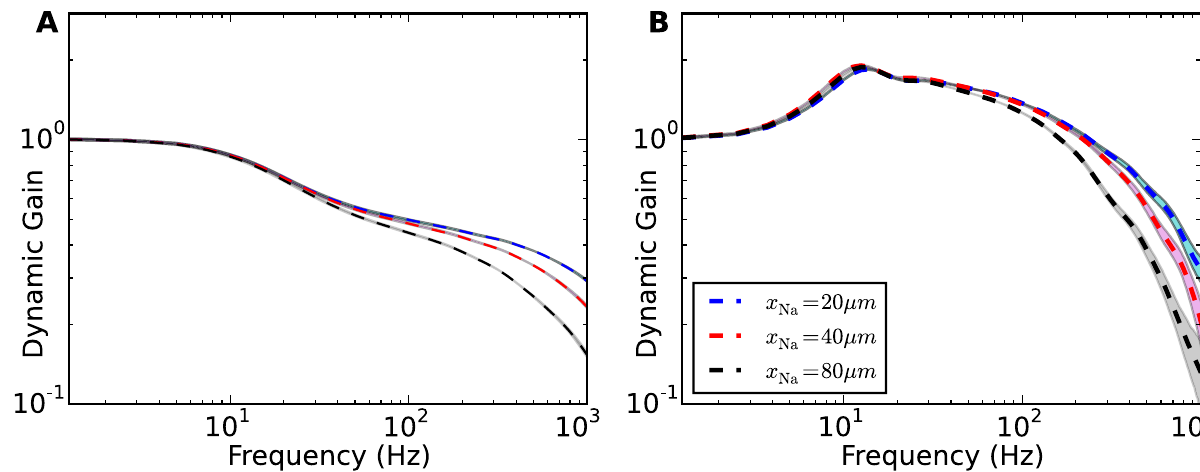
Fig 8. Increased impact of current correlation time for high voltage sensitivity. Dynamic gain curves are plotted for A a short input current correlation time τ = 5ms and B a long correlation time of τ = 50ms. Dashed lines as in Fig 7B. Shaded areas are 95% confidence intervals. Colors denote different initiation site positions (see